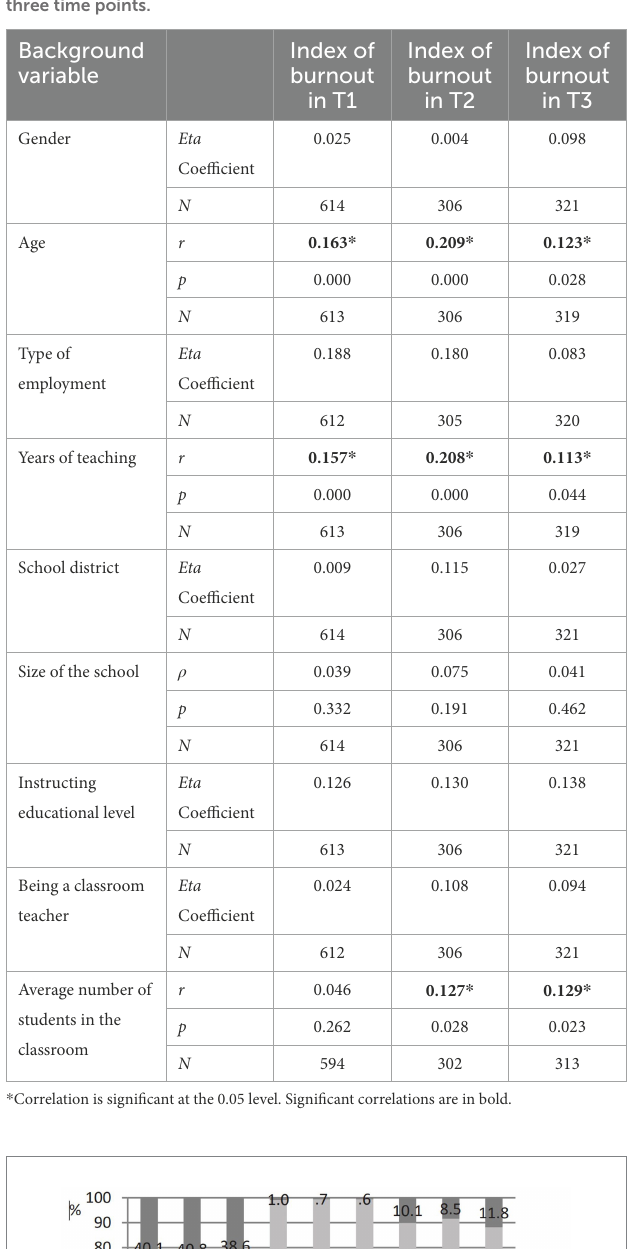
TABLE 2 Correlation analysis of background variables and burnout index in three time points.